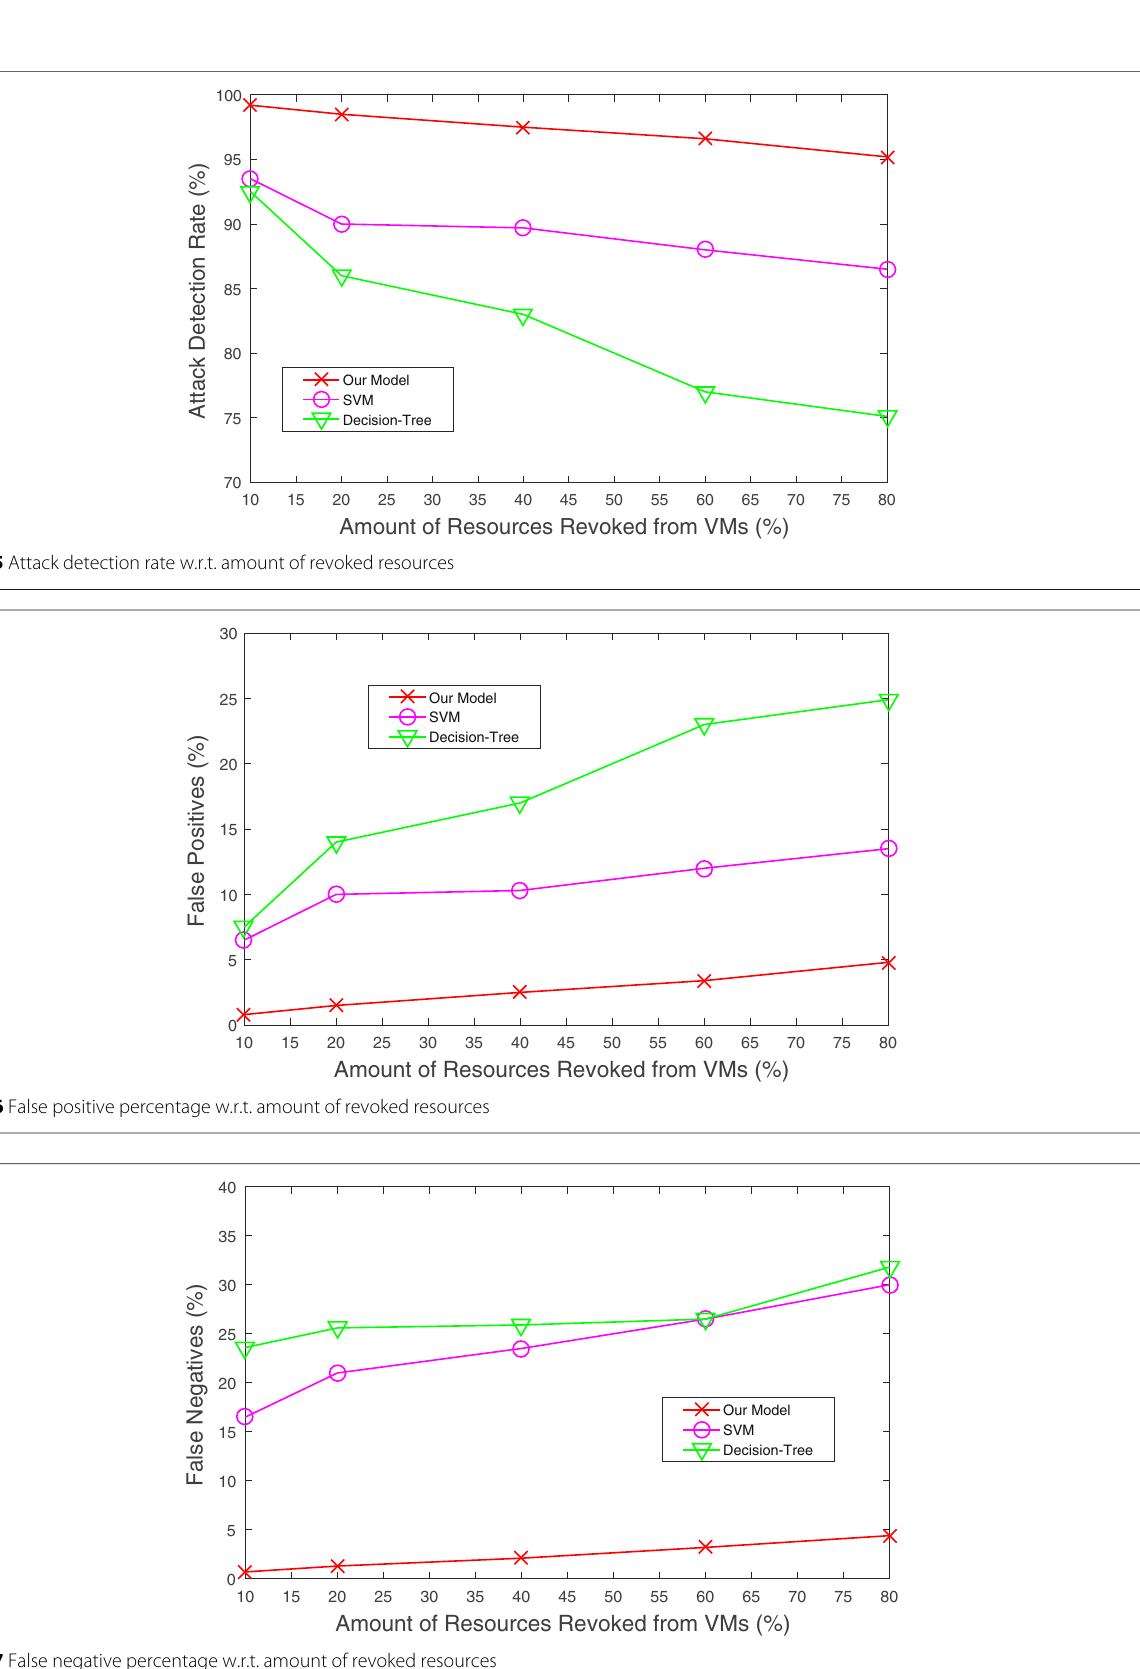
Fig. 7 False negative percentage w.r.t. amount of revoked